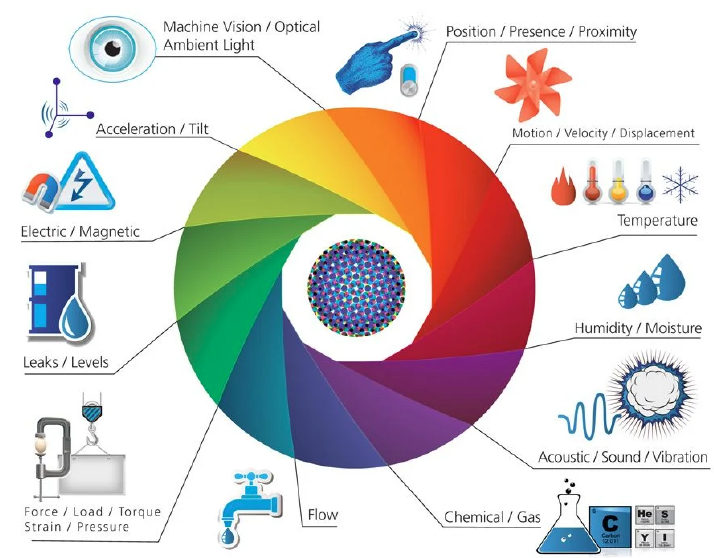
Figure 8. Sensors and actuators currently deployed in the IoT domain